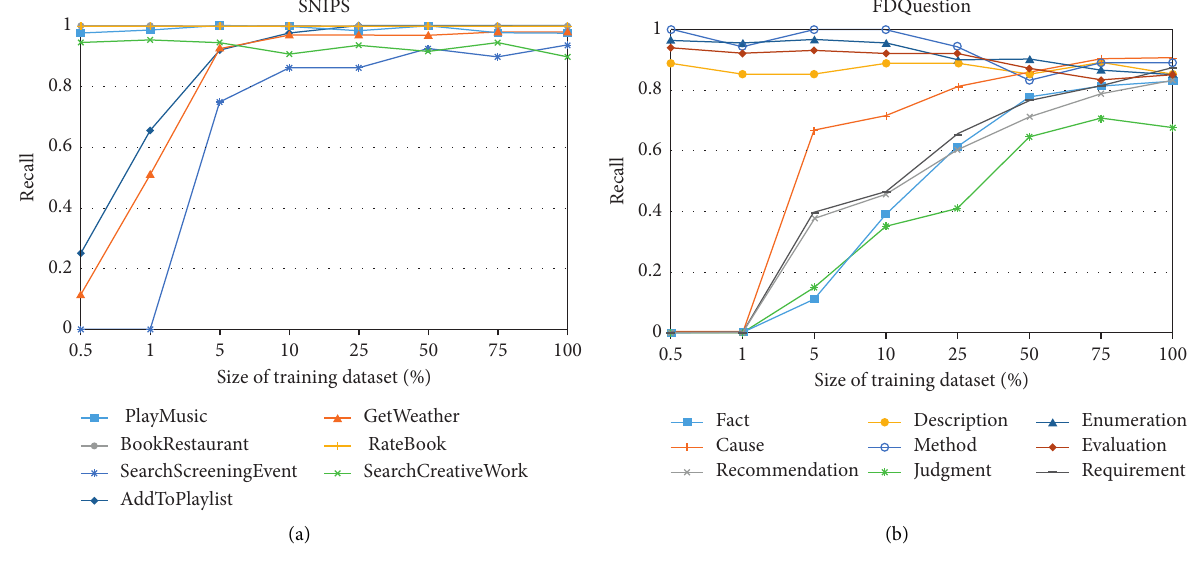
Figure 4: The change of the recall on SNIPS and FDQuestion. (a) SNIPS. (b) FDQuestion. Table 6: The performance comparison of different methods using F 1 score